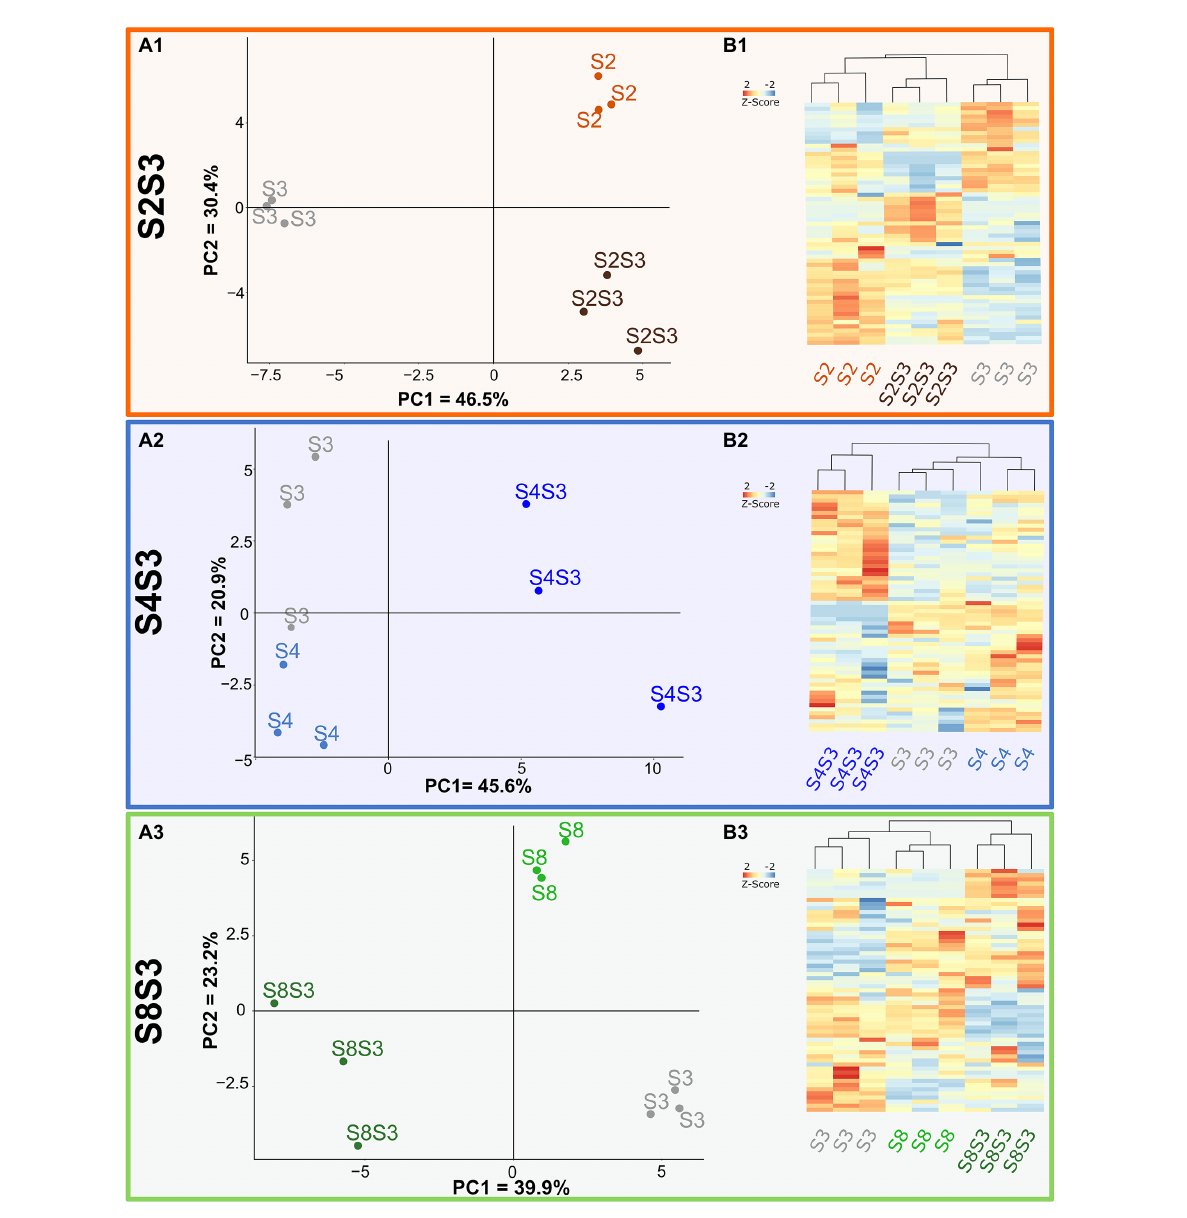
FIGURE 3 Impact of cocultures on volatilome composition. Volatilome analysis (A) PCA of data of Chardonnay wines from pure cultures and coculture for each modality S2S3 (A1), S4S3 (A2), S8S3 (A3). (B) Heatmap representing different compounds in pure cultures and